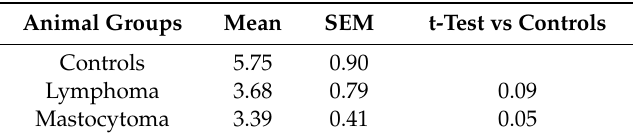
Table 2. OSi E (O 2 • - / SOD) × 100